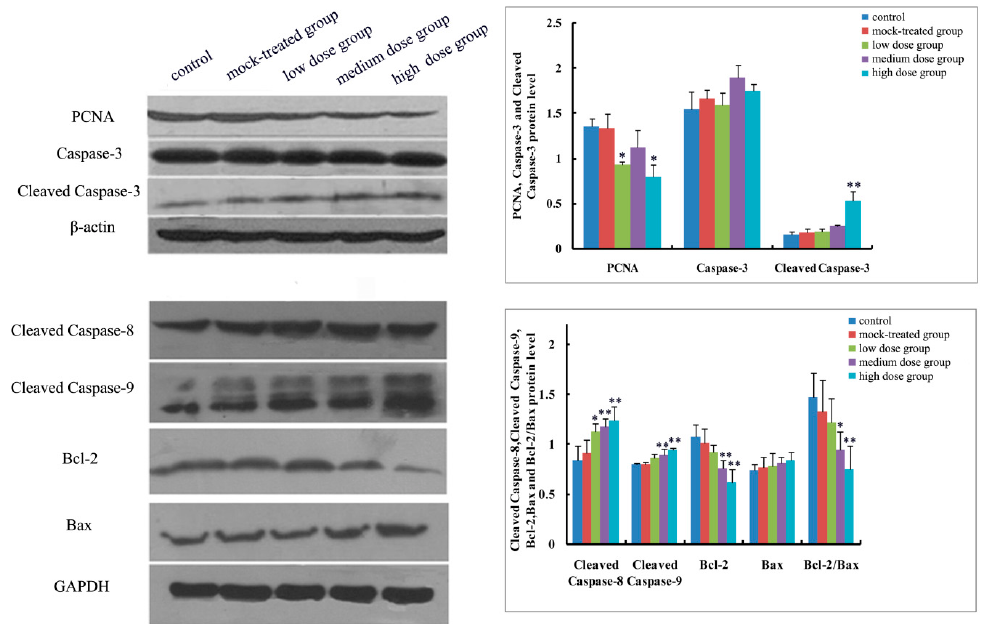
Figure 8. Expressions of apoptosis-related proteins (Caspase-3, Cleaved Caspase-3, Cleaved Caspase-8, Cleaved Caspase-9, Bcl-2, Bax and Bcl-2/Bax) and PCNA in cerebral cortex of mice offspring on postnatal day 21 after maternal exposure to PM 2.5 during pregnancy. Left: the results of western blot; Right: histogram of relative protein levels. * p < 0.05, compared with control; ** p < 0.01, compared with control.